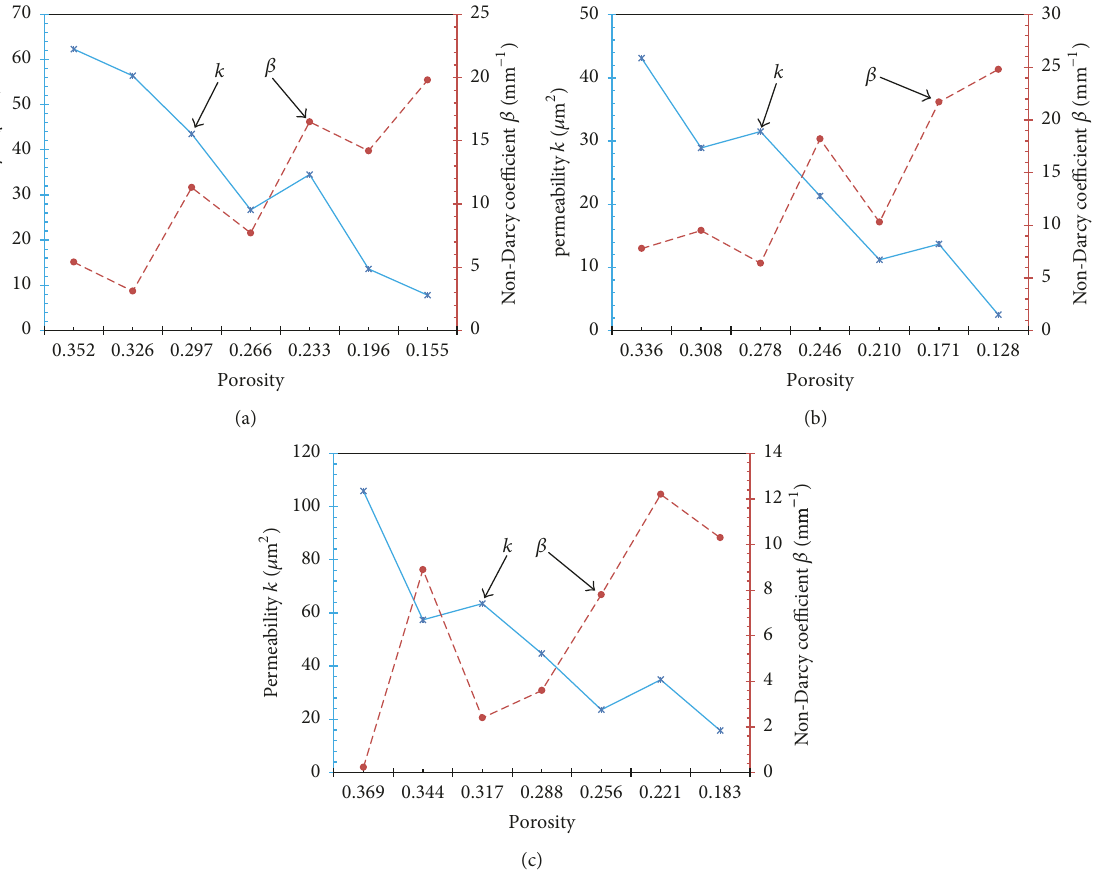
Figure 5: Flow characteristics porosity for each sample: (a) sample a; (b) sample b; (c) sample